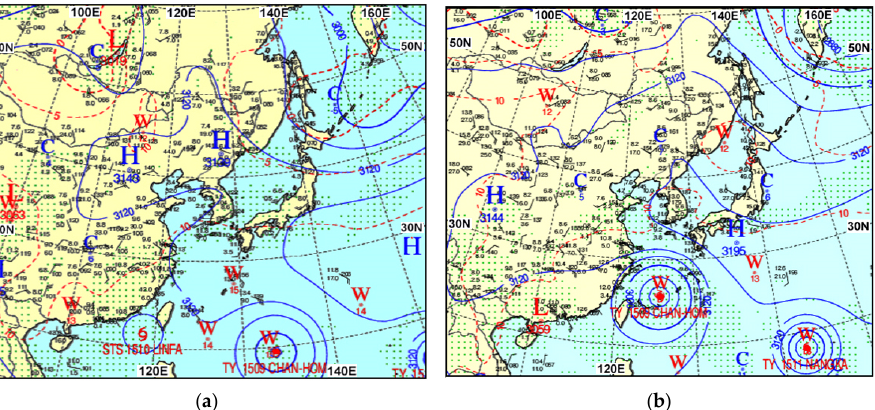
Figure 16. ( a ) Geopotential analysis (m) at 700 hPa (3 km height) at 09:00 LST, 8 July, and ( b ) at 09:00 LST, 10 July. Small green-colored dots from southwest to northeast denote the MLCT. In ( b ), STS Linfa making landfall on the Chinese coast weakened to low pressure by increasing friction of the land and shallower sea bed. The much stronger TY Chan-Hom absorbed moisture from STS Linfa and weakened its circulation, causing the dissipation of Linfa finally.